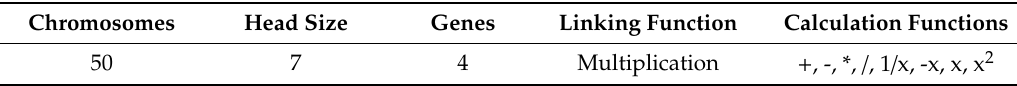
Table 4. The construction of a